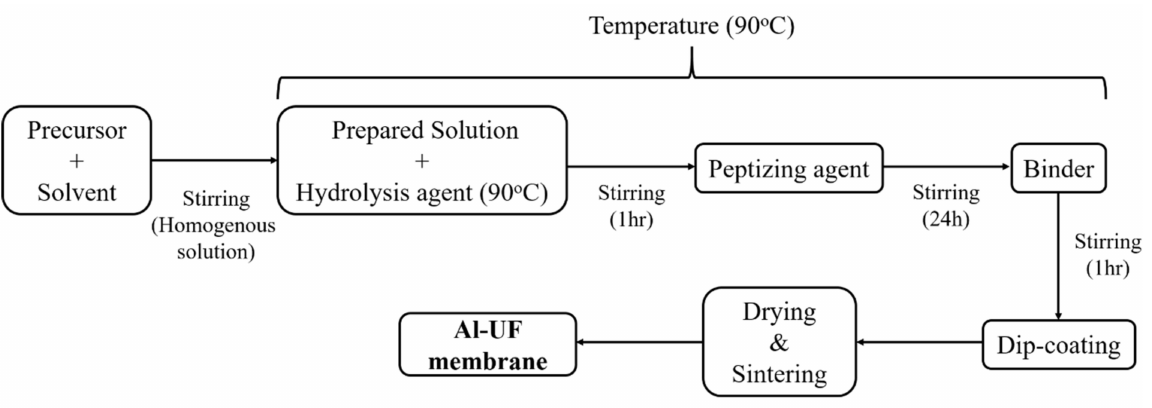
Figure 1. Flow diagram for the preparation of the Al 2 O 3 ultrafiltration (UF)